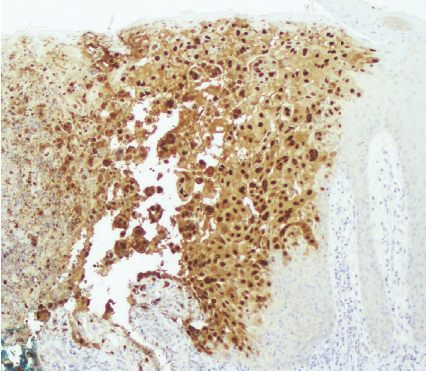
Figure 3: Psoriasis herpeticum. Biopsy specimen from Figure 2 showing positivity with HSV type I immunoperoxidase staining (herpes simplex virus type I immunoperoxidase stain; original magnification: ×